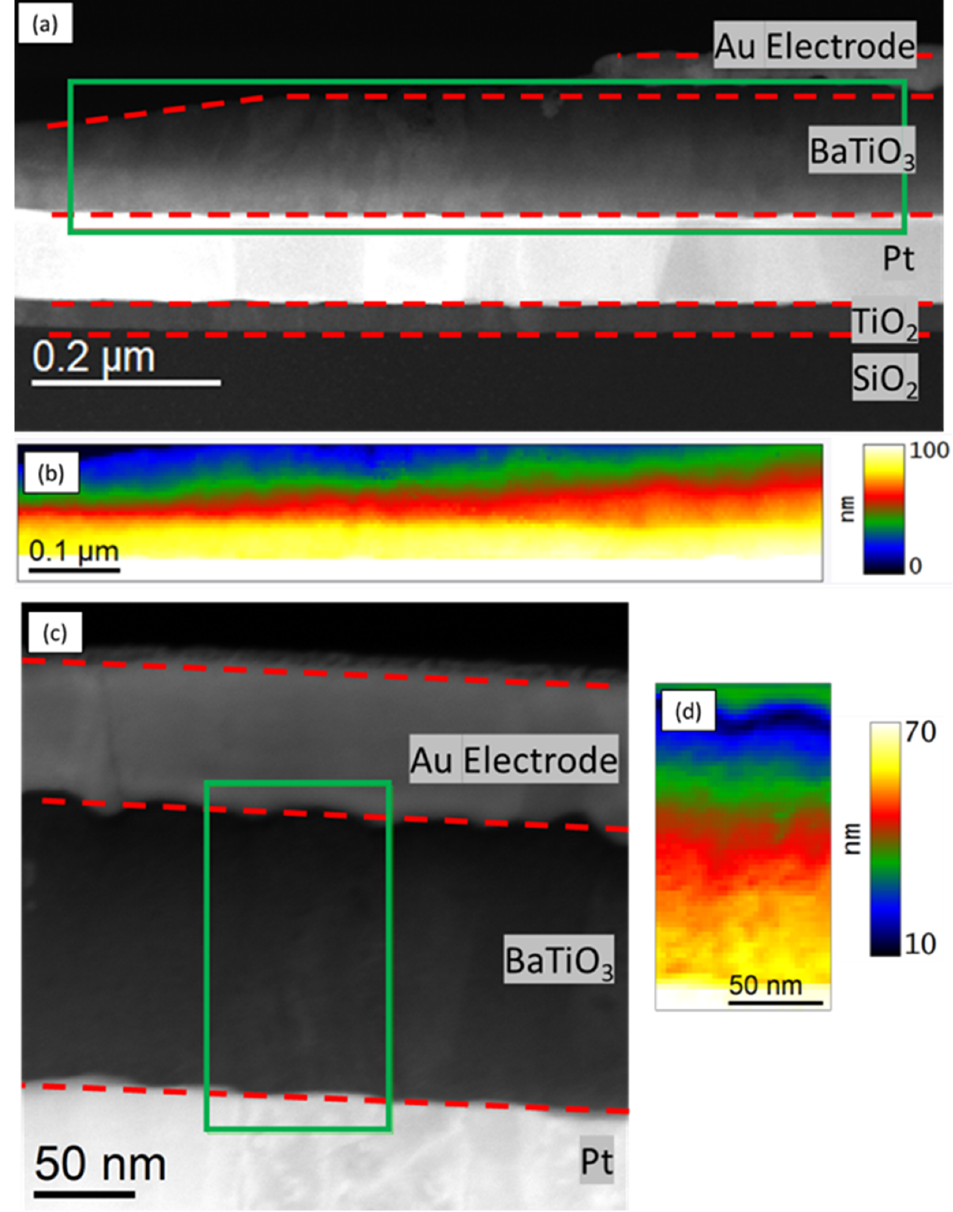
Figure 2. ( a ) STEM HAADF (high angle annular dark field) image of the BaTiO 3 sample made by wedge polishing. ( b ) Thickness map measured by EELS within the green rectangle on ( a ). ( c ) Image of the sample made by FIB. ( d ) Thickness map measured by EELS within the green rectangle on ( c ).